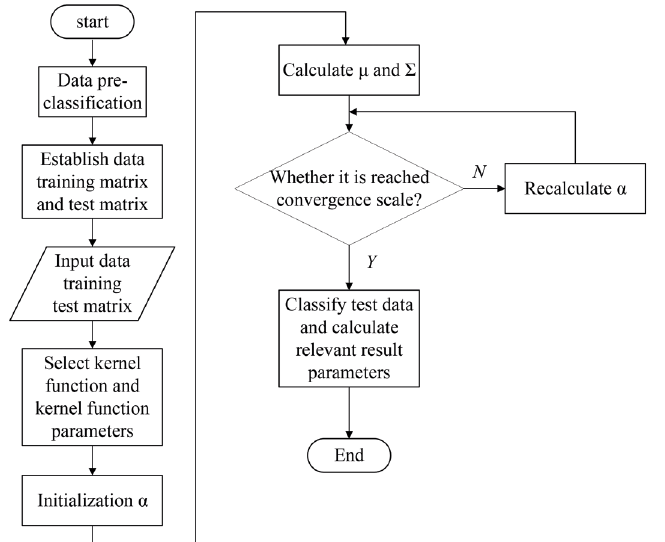
Figure 7. The flowchart of the RVM-based driver sleepiness state recognition